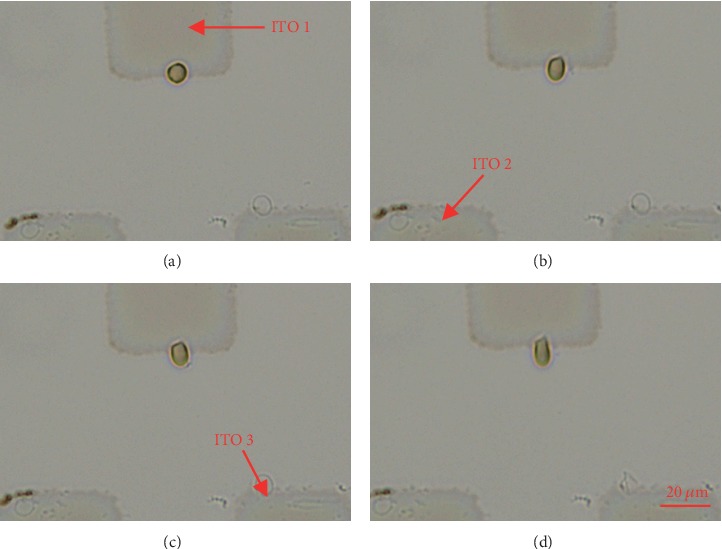
Experimental images of cell stretching. (a) A red blood cell was captured in the middle of ITO electrode 1. (b) A sine wave with 9 Vpp and a frequency of 1.5 MHz was applied between ITO electrodes 1 and 2. (c) A sine wave with the same parameters was applied between ITO electrodes 1 and 3. (d) Two same sine waves were applied between ITO electrodes 1 and 2 and between ITO electrodes 1 and 3.